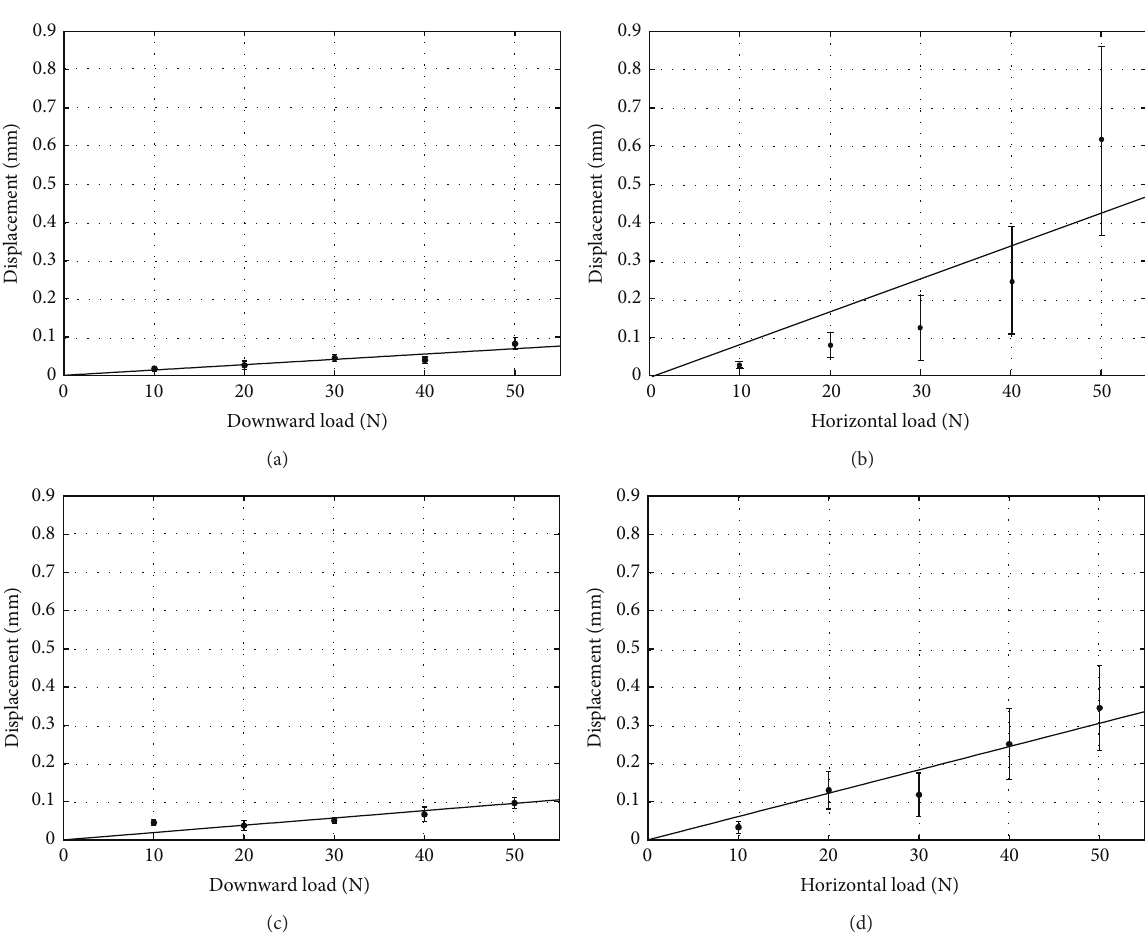
Figure 16: Compressive and shear load-displacement relationship graph of holding device: (a) displacement to downward force, (b) displacement to horizontal force on flat plate, (c) and (d) graph of displacement to downward and horizontal force on phantom. Solid line is a fitting line that shows the relationship between load and displacement when the device deforms in the elastic deformation range as a real solid object.